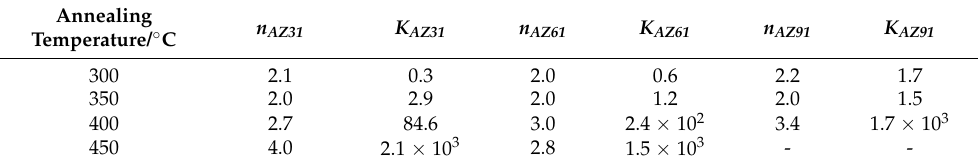
Table 2. The values of the fitted parameters n , and K for Mg–xAl–1Zn (x = 3, 6, 9) alloys at different annealing